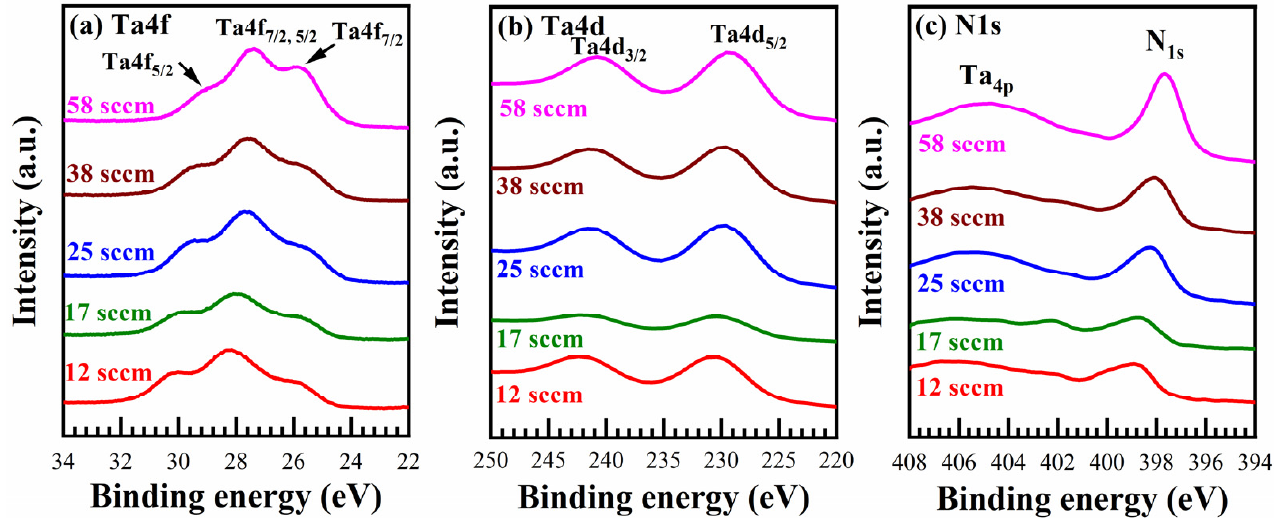
Figure 6. XPS core levels spectra of ( a ) Ta4f, ( b ) Ta4d and ( c ) N1s for the TaN films at different N 2 flows (12–58 sccm, 10 min deposition).